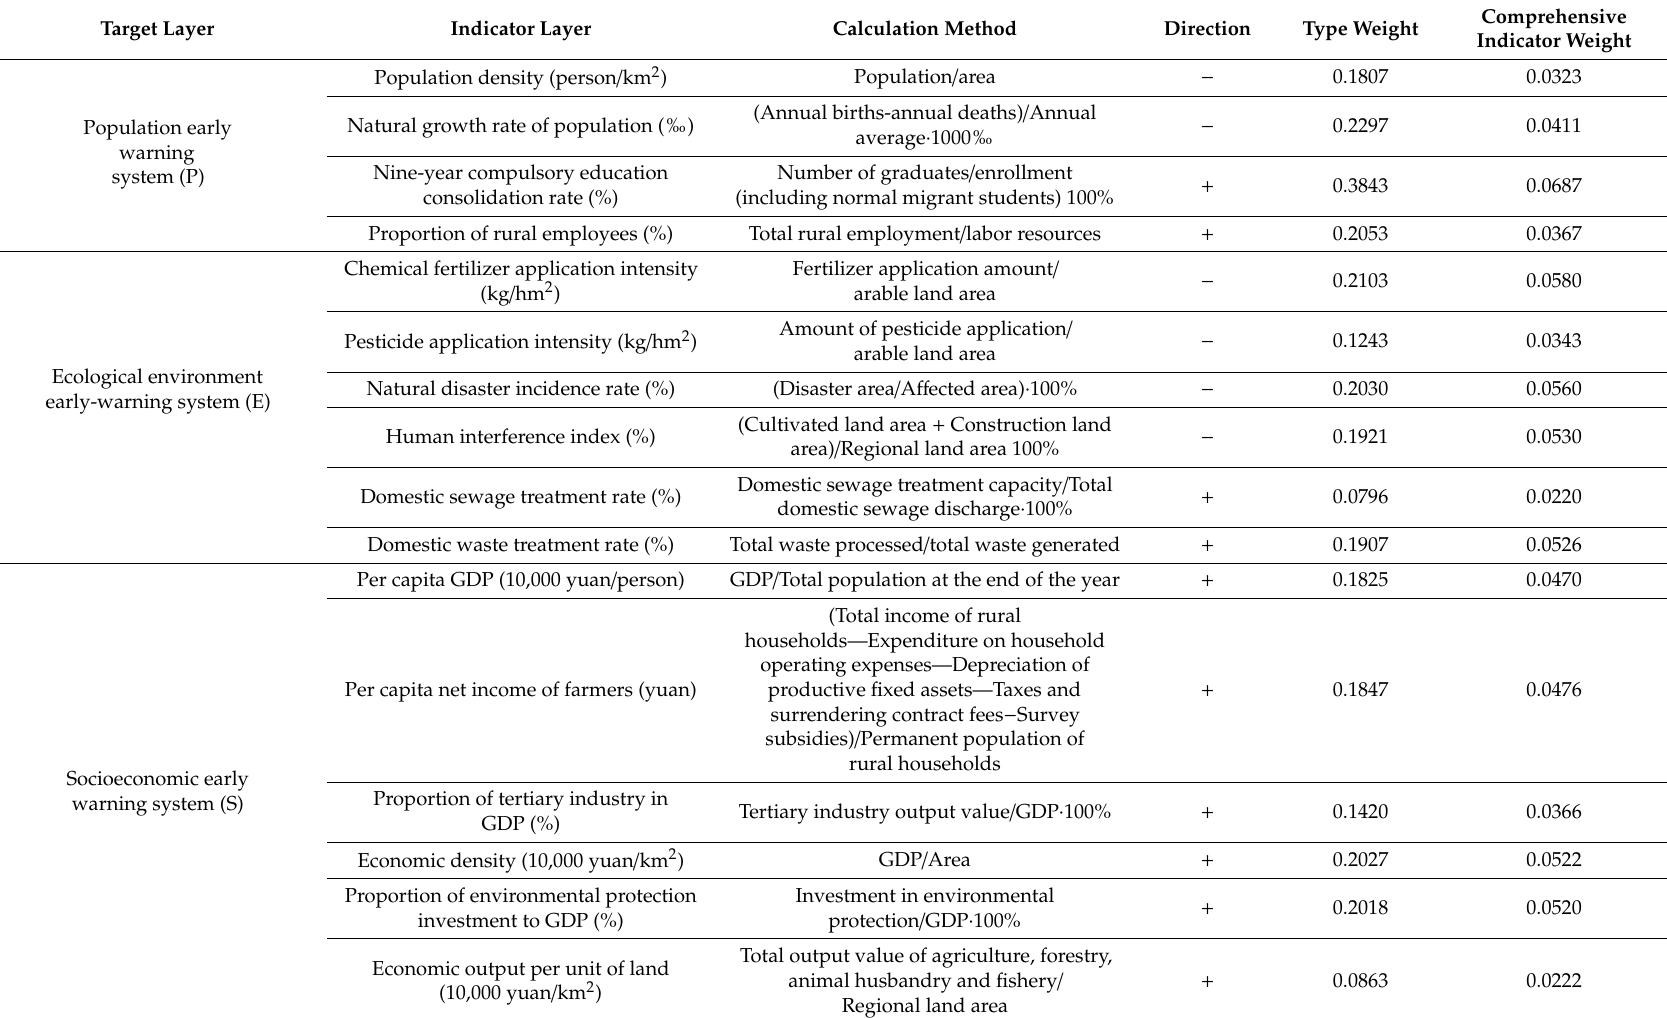
Table 4. The system of indexes used for the Qinghai alpine agricultural mountainous area ecological security